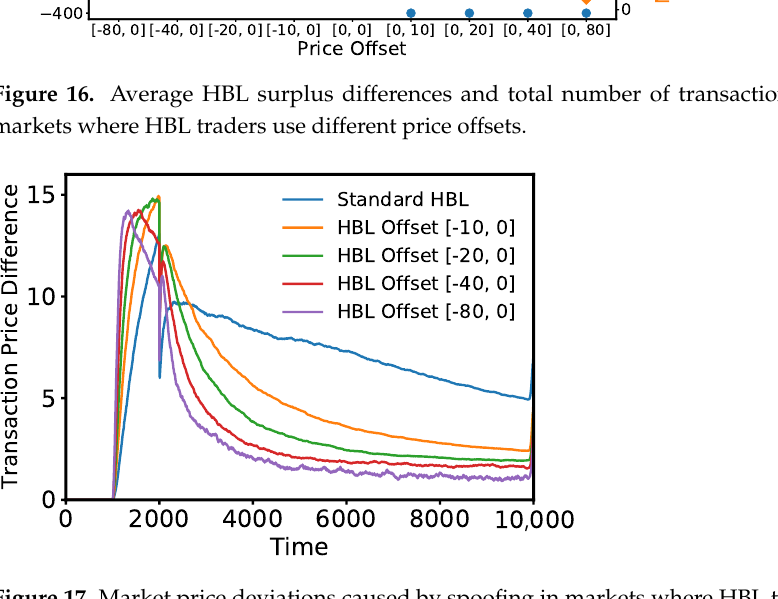
Figure 17. Market price deviations caused by spoofing in markets where HBL traders use different price offsets.